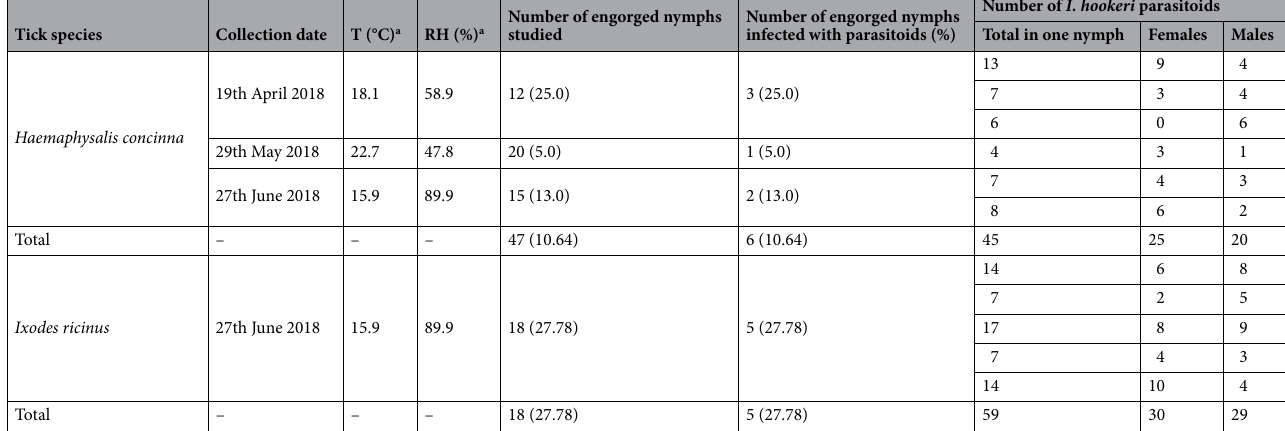
Table 1. Occurrence of endoparasitoid Ixodiphagus hookeri wasps in Haemaphysalis concinna and Ixodes ricinus nymphs in the Slovak Karst, Slovakia. a Temperature (T) and relative humidity (RH) in the habitat during tick